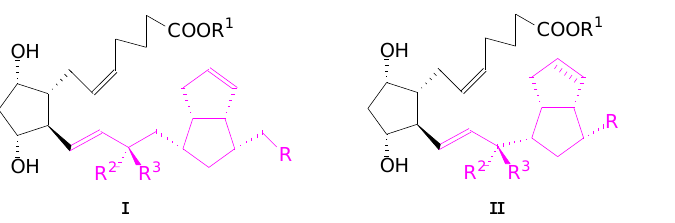
Figure 1. Prostaglandin analogs of type I with a bicyclo[3.3.0]octene fragment and respectively of type II with bicyclo[3.3.0]octene and bicyclo[3.3.0]octane fragments in the ω-side chain.